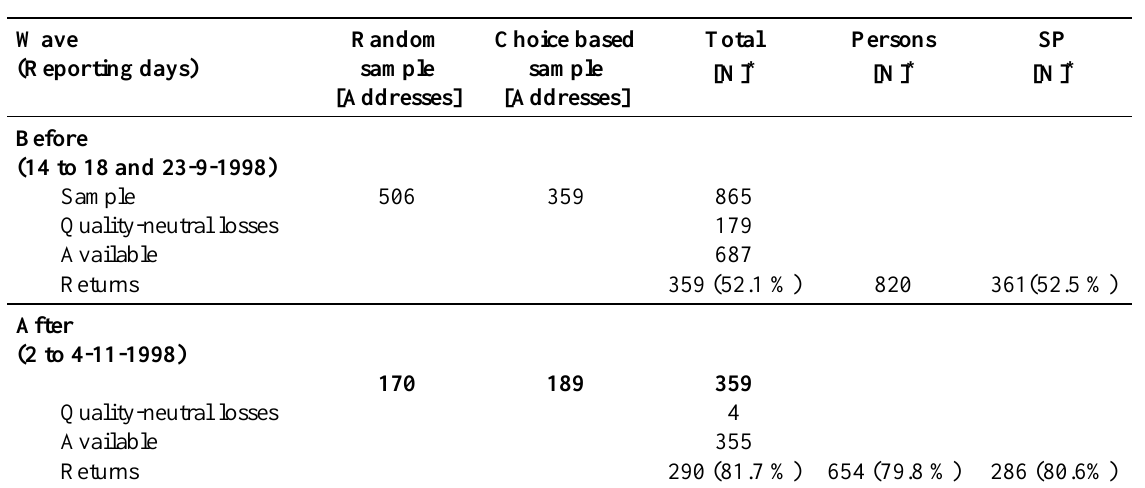
Table 1. Response